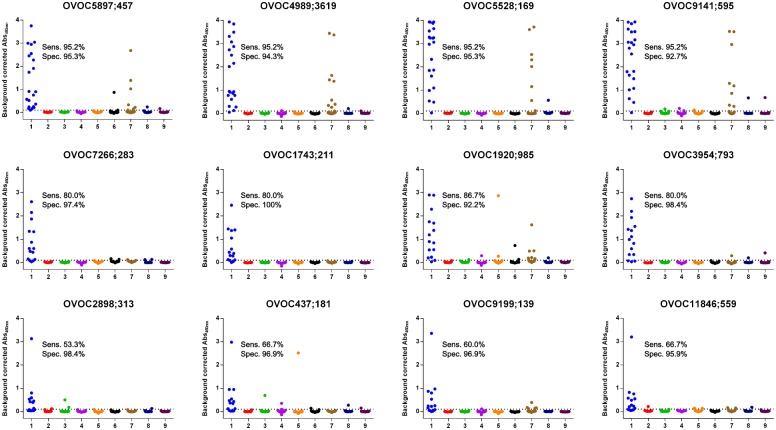
Assessment of immune response against peptides with motifs using peptide ELISA.Immunoreactivity against the 12 selected peptides was determined in a set of 21 O. volvulus infected individuals (group 1), healthy controls from Southern Africa (group 2), healthy controls from Belgium (group 3) and individuals infected with HIV (group 4), HCV (group 5), Dengue (group 6), P. falciparum (group 7) and W. bancrofti (group 8) and asthma patients (group 9).